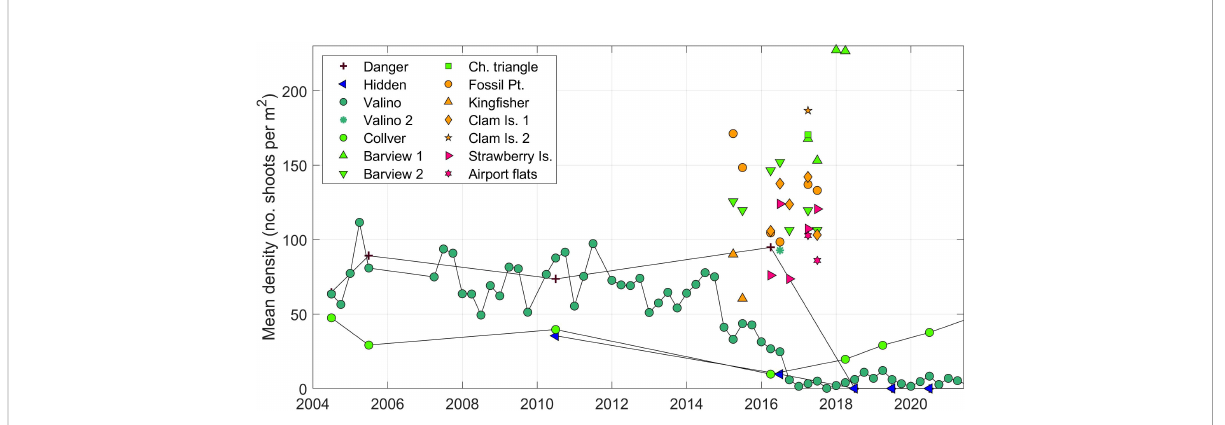
FIGURE 9 Density of eelgrass (number of shoots m 2 ) until present for all eelgrass measurements from stations shown in Figure 2B and Supplemental Figure 1B. Stations are colored by general areas: purple to green = South Slough, yellow to pink = main channel. Connected symbols correspond to the stations shown in Figure